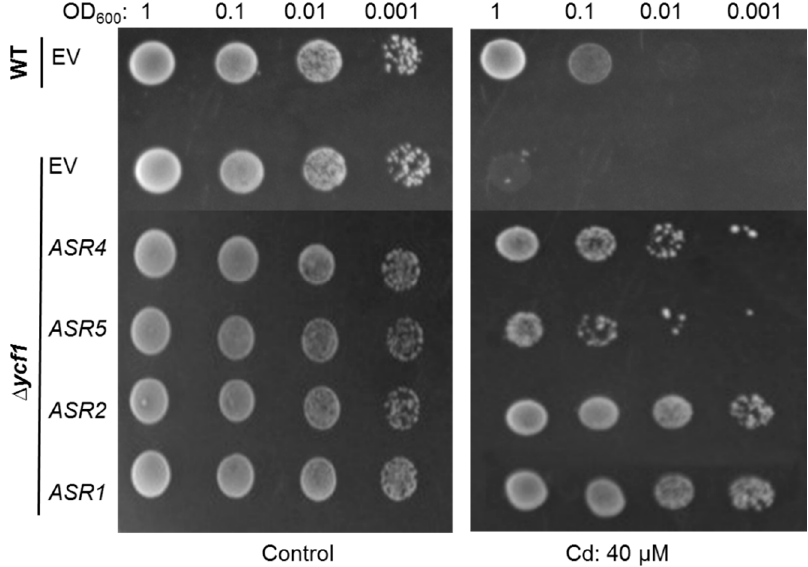
Figure 3. Maize ZmASR genes confer Cd-tolerance in yeast. The survival test of yeast strains transformed with maize ZmASR or pYES2 empty vector ( EV ) on SG-Ura agar medium supplemented with 40 µ M CdCl 2 in the presence of 2% galactose. Yeast cells transformed with EV were used as control.